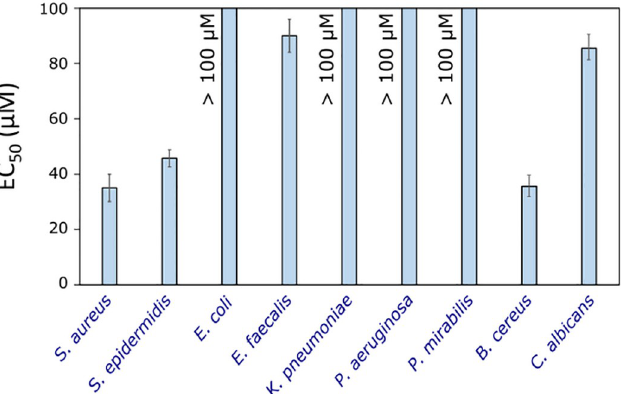
Fig 4. Antimicrobial activity of compound 16b in a liquid medium, expressed as half maximal effect concentration (EC 50 values), n =